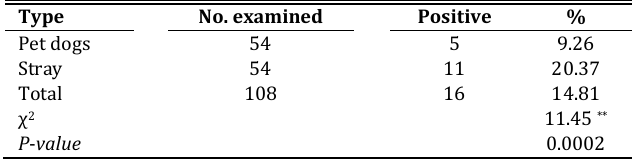
Table 1. Dipylidium caninum infection rate in pet and stray dogs' fecal